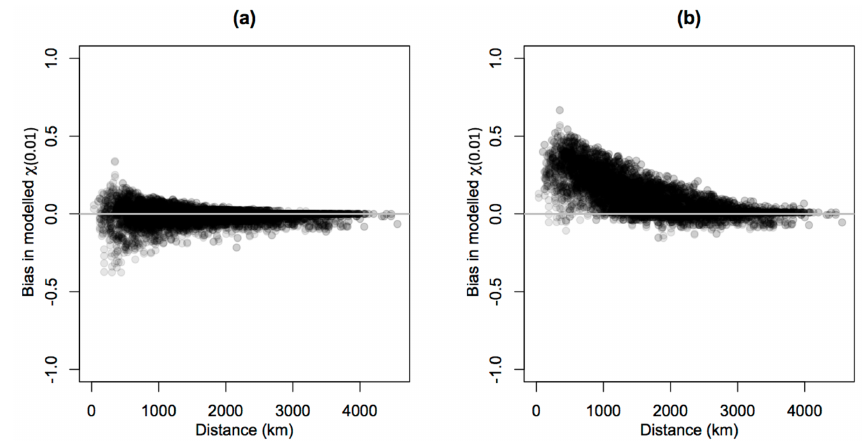
Figure 9. The difference between empirical and modelled χ (0.01) for a stratified sample of 100 locations paired with each of the other 99 locations, plotted against separation distance for (a) the Gaussian model and (b) the Gumbel model.